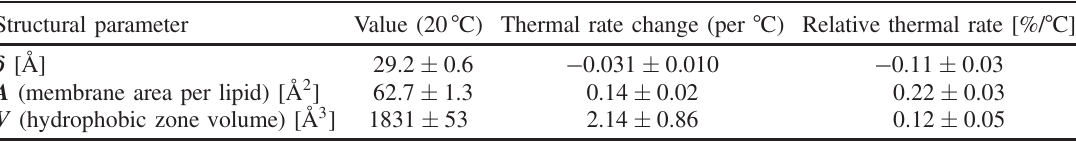
TABLE II. POPC membranes ’ thermal dimensional change parameters used in the theoretical framework (see Refs.